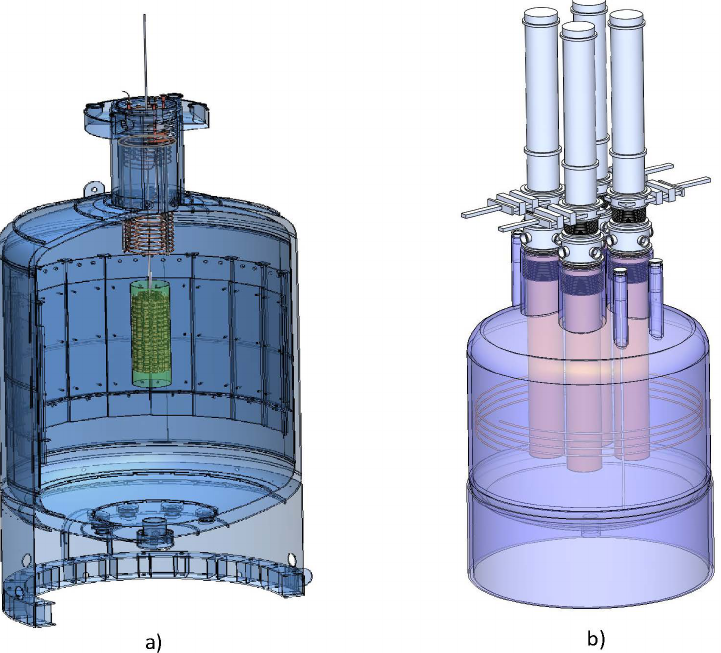
Figure 13. Experimental setup of the LEGEND-200 ( a ) and LEGEND-1000 ( b ) phase, respectively. LEGEND-200 will deploy 20 kg of BEGe and 9.4 kg of ICPC detectors (see Figure 5b,c) from G ERDA and 28 kg of PPC detectors from M AJORANA . In addition, nearly 140 kg of newly produced ICPC detectors will be added. As discussed in Sections 5.1 and